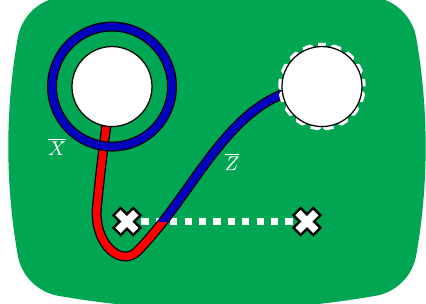
FIG. 16. A hybrid qubit is encoded using a pair of holes — one with a rough boundary and one with a smooth boundary — and one pair of twist defects. The two anticommuting logical operators of the hybrid qubit are